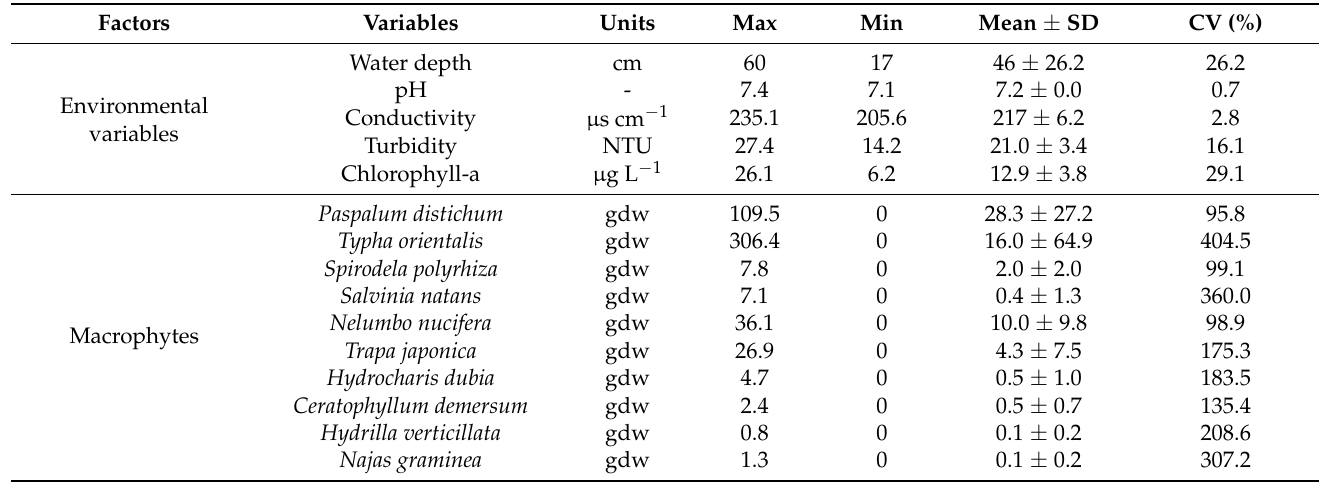
Table 1. Mean physicochemical parameters and macrophytes measured at 50 sampling sites.